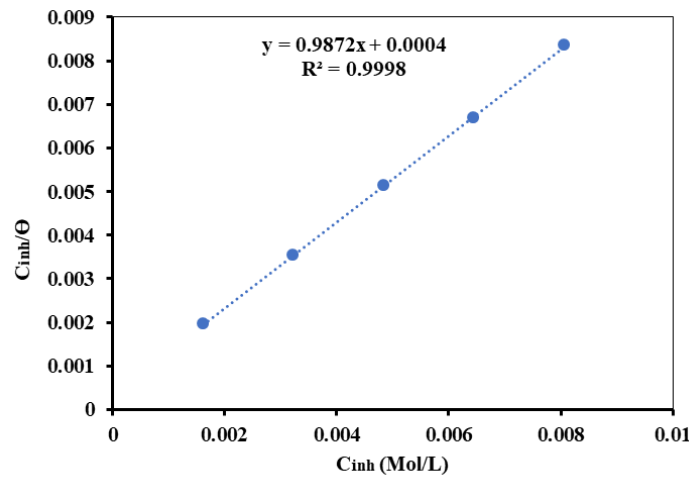
Figure 6. Langmuir adsorption isotherm plot for MS in 1 M H 2 SO 4 with different inhibitor concentrations.